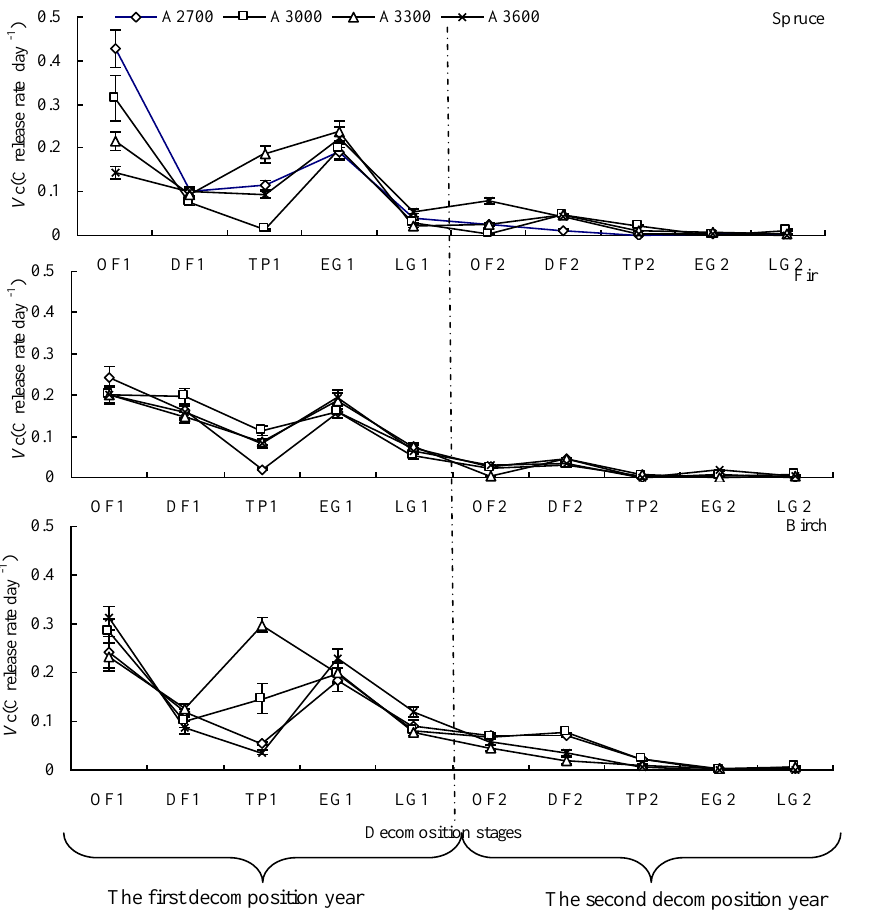
Figure 4. Carbon release rate per day ( V c ) for foliar litter of the three species investigated at different decomposition stages along an altitudinal gratitude from 2700 to 3600m. Bars indicate SE; n =